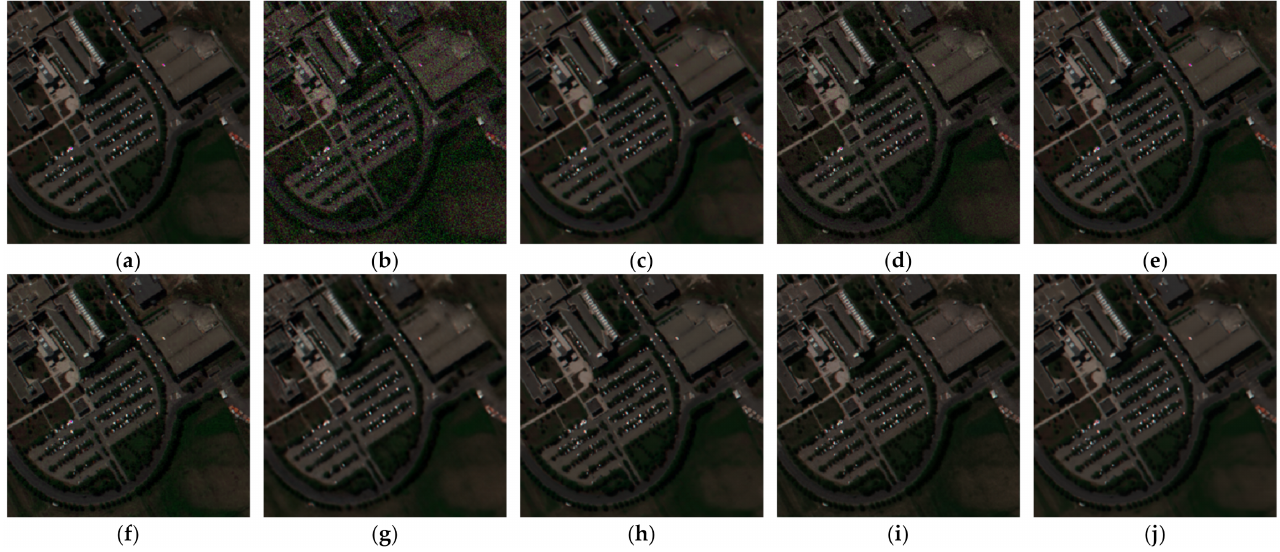
Figure 9. Case 2—Denoising results of different algorithms in RGB (45,15,5): ( a ) clean image; ( b ) noisy band; ( c ) BM4D; ( d ) LRMR; ( e ) HyRes; ( f ) L1HyMixDe; ( g ) DHP-2D; ( h ) SIP; ( i ) SURE-CNN; and ( j )